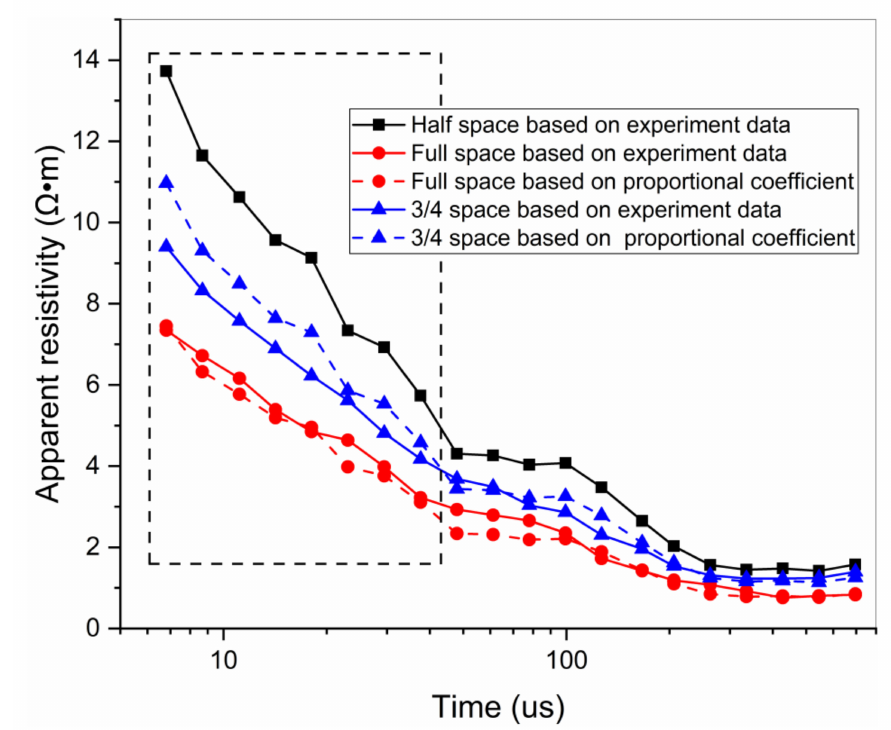
Figure 15. Apparent resistivity inversion results of three ideal space